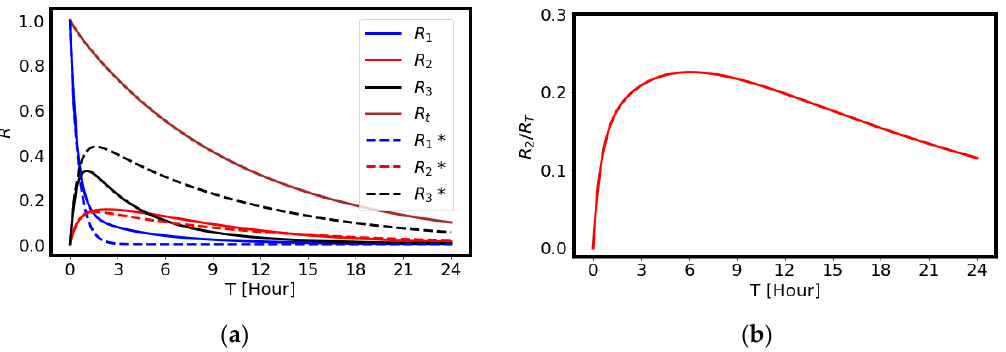
Figure 2. The calculated results of radioactivity in each box. ( a ) The amounts of radiating materials in blood ( R 1 ), tumor ( R 2 ), body ( R 3 ), and total activity ( R T ) for the case where the initial amount is set to R 1 = 1. The solid curves are calculated rigorously, including the return paths, while the dashed curves are those of the analytical expressions without considering the return paths. ( b ) The amount of the radiating material in the tumor considering the decay rate y is shown as a function of time.